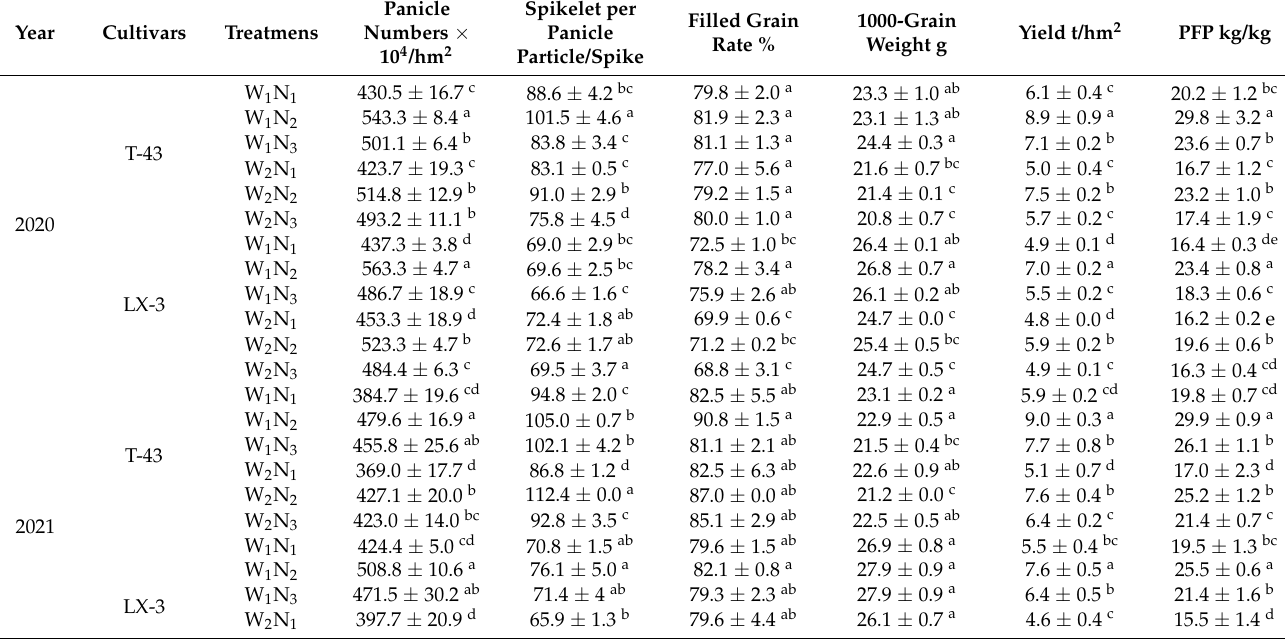
Table 3. Effects of water and nitrogen management on rice yield and its components under drip